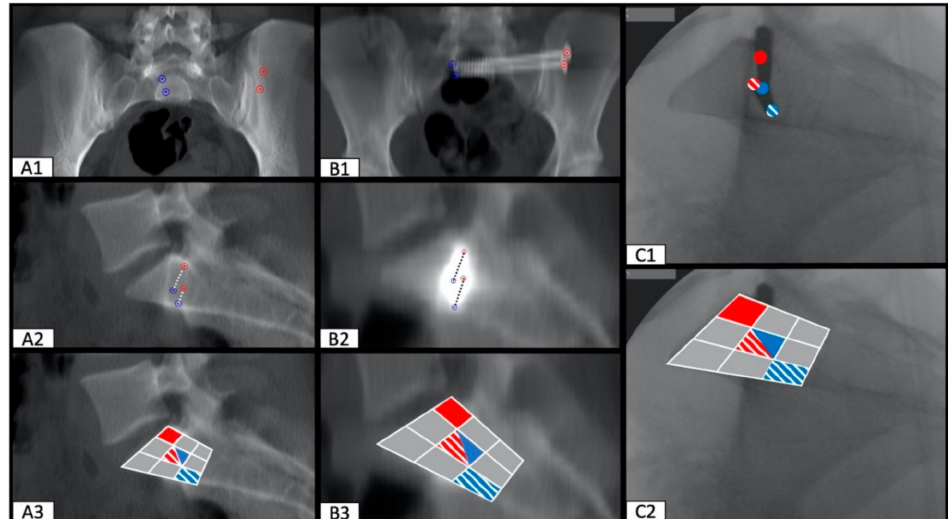
Figure 5. Positioning of two SI screws in a patient with a dysmorphic osseous corridor (entry- and endpoint diverge significantly). Predicted entry- (red circle) and endpoint (blue circle) of the perfect osseous corridor preoperatively ( A1 ). Actual entry- (red circle) and endpoint (blue circle) of the inserted SI screw ( B1 ). Intraoperative fluoroscopy image with an inserted k-wire, the red circle shows the entrypoint at the lateral iliac corticalis, the blue circle the tip of the k-wire ( C1 ). Visualization of the predicted ( A2 , A3 ), actual ( B2 , B3 ) and intraoperative ( C2 ) entry- and endpoint of the SI screw using the nine segment division of the S1 vertebral